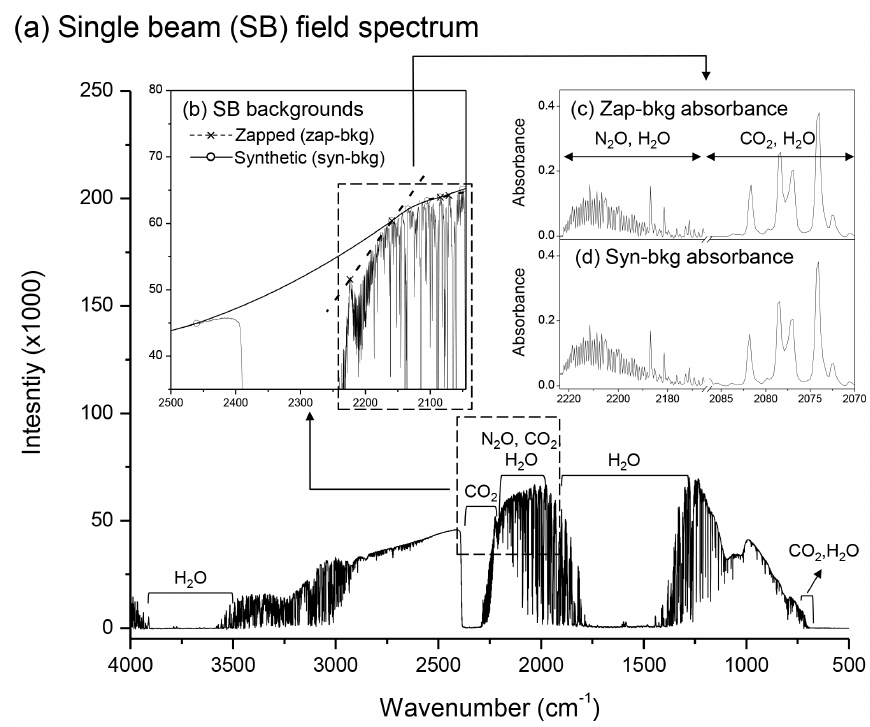
Figure 3. The illustrations of (a) a field single-beam (SB) OP-FTIR spectrum containing the regions of N 2 O, CO 2 , and water vapour collected through an optical path length of 300m; (b) zapped and synthetic SB backgrounds (zap-bkg and syn-bkg) generated from this field SB spectrum and used to convert the sampled SB spectrum to (c) the absorbance spectra that allowed the calculation of N 2 O / CO 2 concentrations using the Beer–Lambert